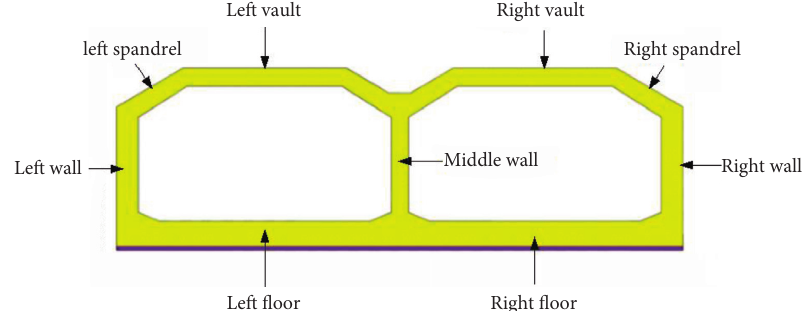
Figure 4: Arrangement of measuring points.